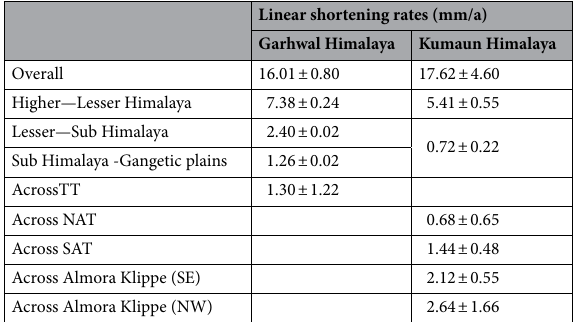
Table 2. Estimated linear shortening rates across the Garhwal and the Kumaun Himalaya.